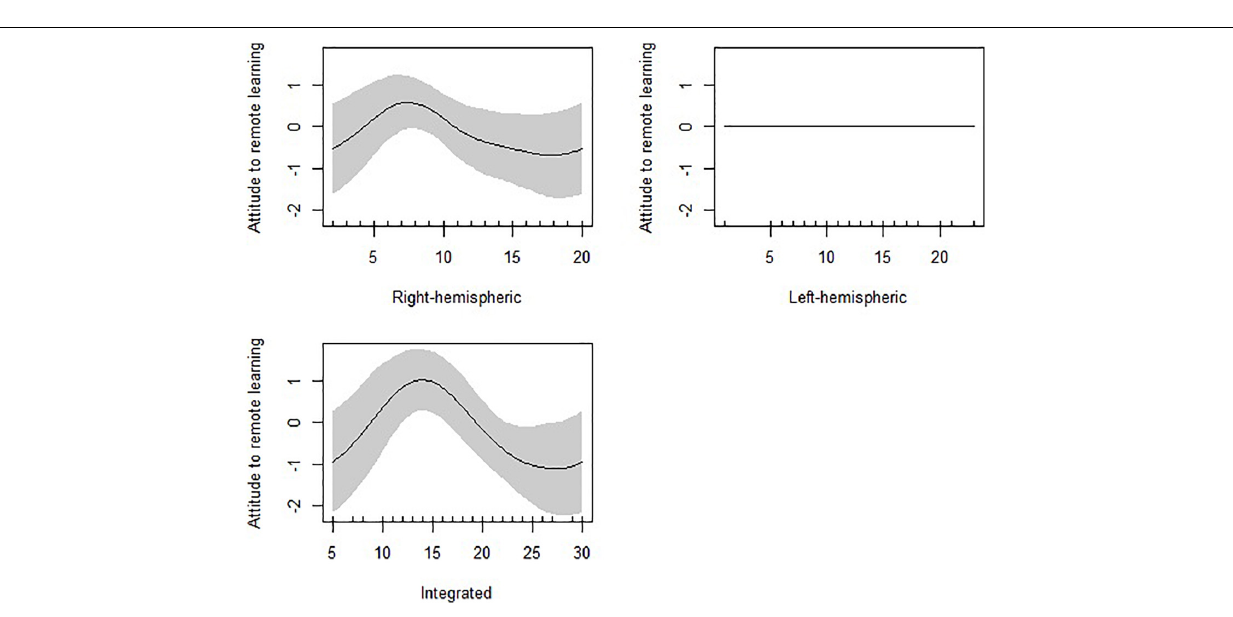
FIGURE 3 | GAM components (partial prediction), plots with 95% confidence intervals. Thinking and learning styles